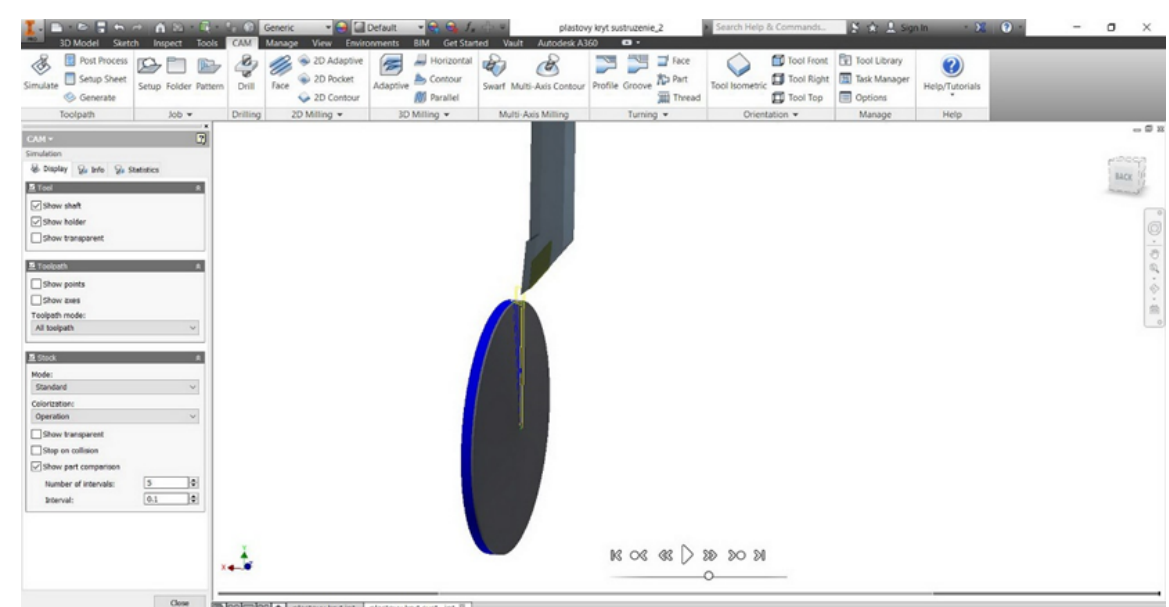
the coordinate system in the centre of the part rotation and its machined face was chosen. see Figure 3. This was followed by the choice of the tool, a right side turning cutting blade. Adjusting its shift extent, 0.1 mm.ot- 1 feed and 850 rev.min-1 speed required for external face area and cylindrical area machining - Figure